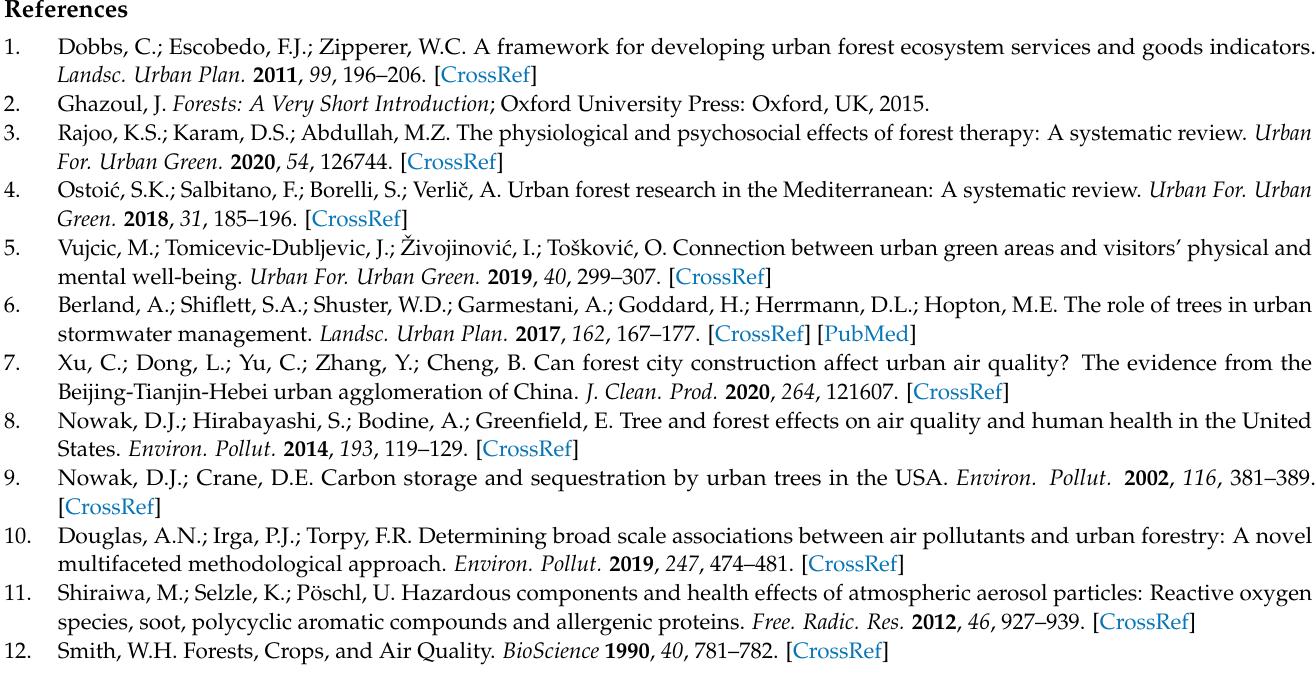
B. pendula , C. avellana and Q. robur . Figure S2: Average and standard deviation in pollen soluble protein content of A. negundo , B. pendula , C. avellana and Q. robur . Figure S3: Average and standard deviation in pollen reactive oxygen species (ROS) content of A. negundo , B. pendula , C. avellana and Q. robur . Figure S4: Average and standard deviation in pollen NADPH oxidase enzymatic activity